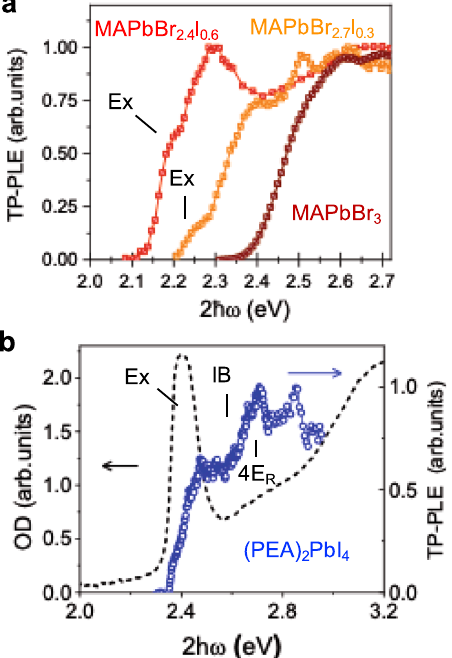
Fig. 5 Broken inversion symmetry and Rashba splitting in mixed-halide perovskite crystals and 2D PEA 2 PbI 4 . a Room temperature two-photon photoluminescence excitation (TP-PLE) spectra of mixed halide crystals MAPbBr 2.4 I 0.6 (red squares) and MAPbBr 2.7 I 0.3 (orange squares) compared to that of MAPbBr 3 (brown squares). b TP-PLE spectrum of (PEA) 2 PbI 4 (blue circles) compared to the absorption spectrum of a corresponding thin fi lm (dashed line). The TP-PLE spectra are plotted vs. twice the excitation energy, 2 _ ω ; whereas the absorption is plotted vs. _ ω . The positions of the exciton (Ex) are indicated. In b , the peak due to Rashba splitting (4 E R ) and the inter-band onset (IB) are also